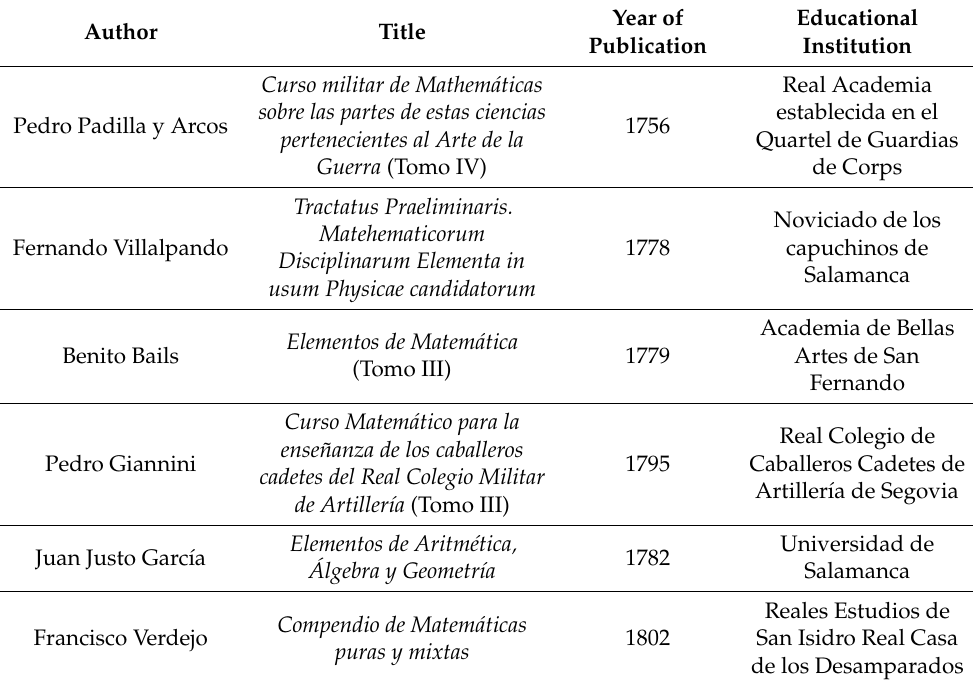
Table 1. Textbooks analysed and institutions to which they were directed